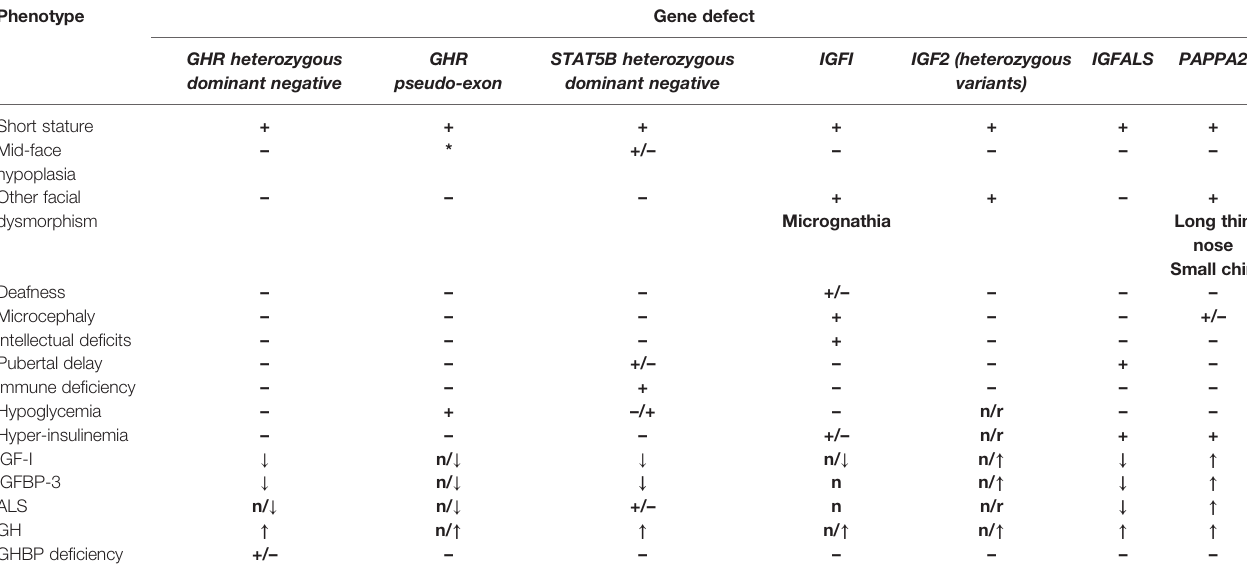
TABLE 1 | Summary of phenotypic and biochemical features of defects causing GH resistance originally labelled as